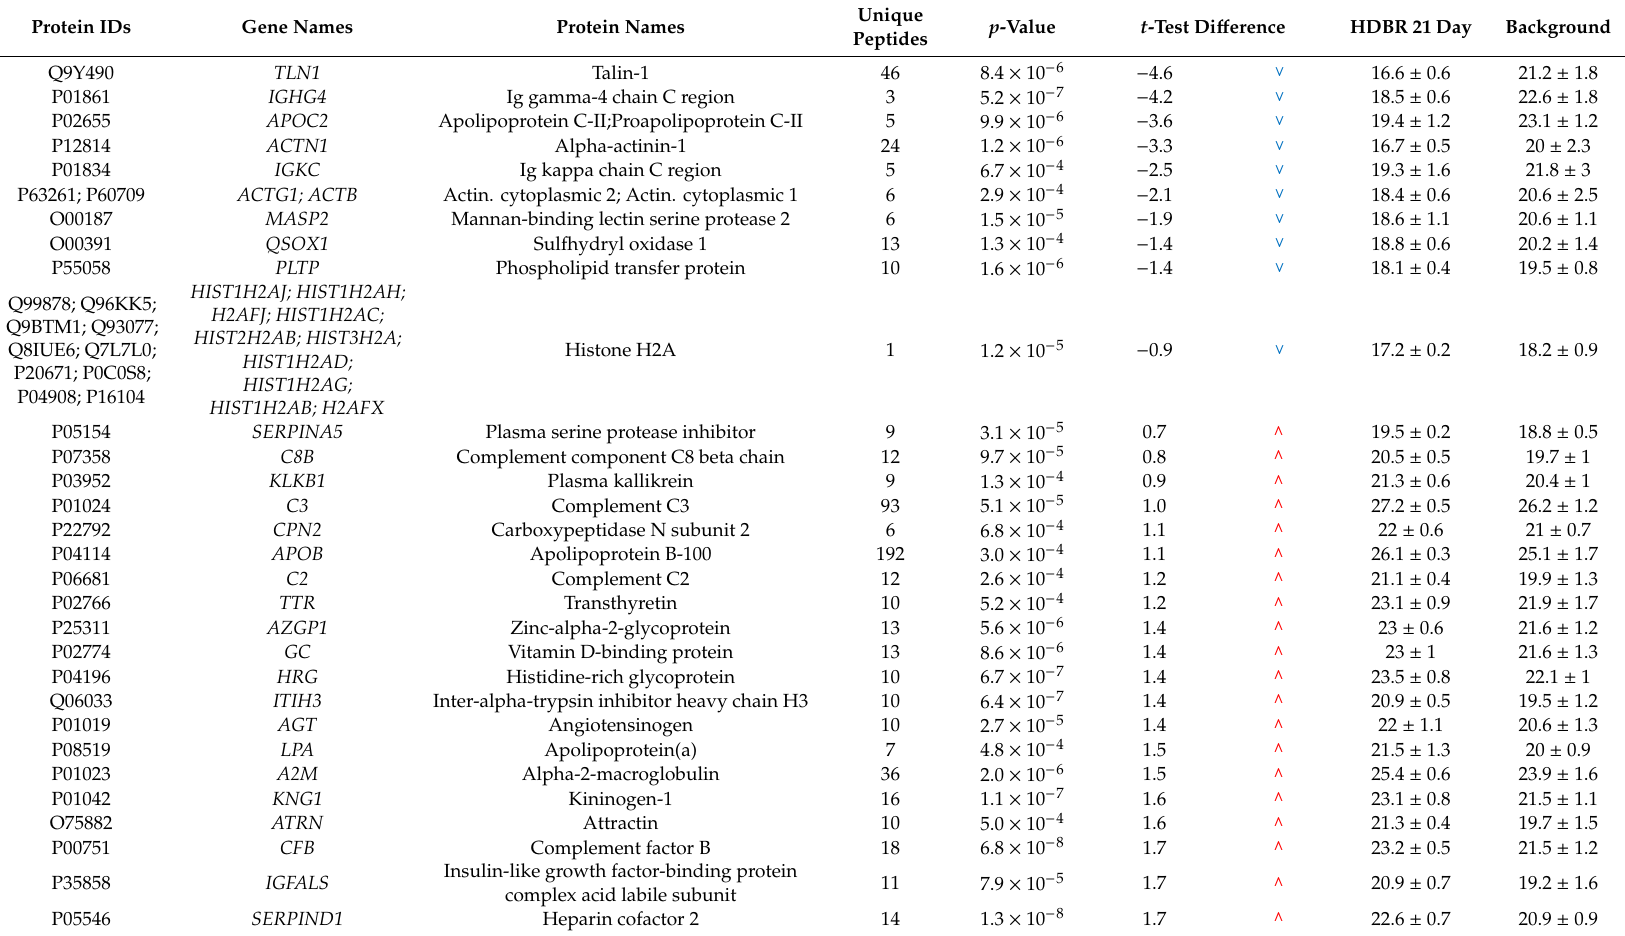
Table 1. The list of proteins significantly changed ( p < 0.01) on the 21st day of the head-down bed rest (HDBR) ground-based experiment with respect to their background levels (the day before the experiment). Proteins were identified by pair-wise comparison (Welch’s t -test). Red/blue symbol—the increase/decrease of the protein level with respect to the background.